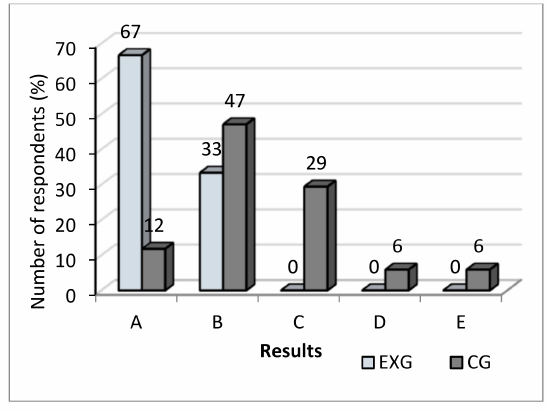
Figure 3. Post-test results in 2017/2018.